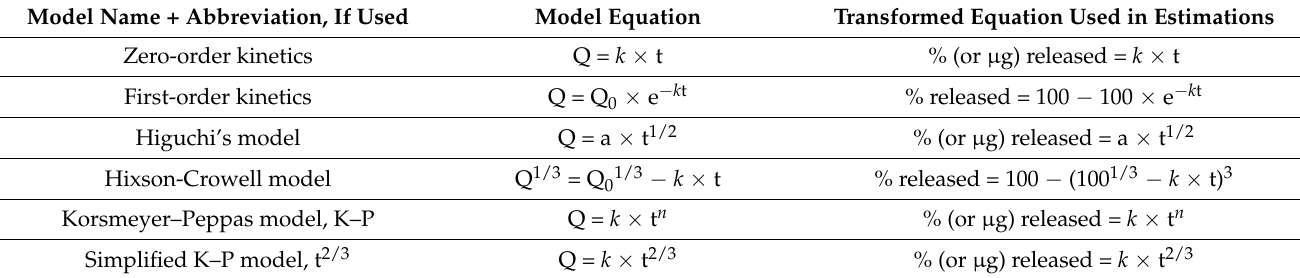
Table 6. Equations of applied kinetic models.